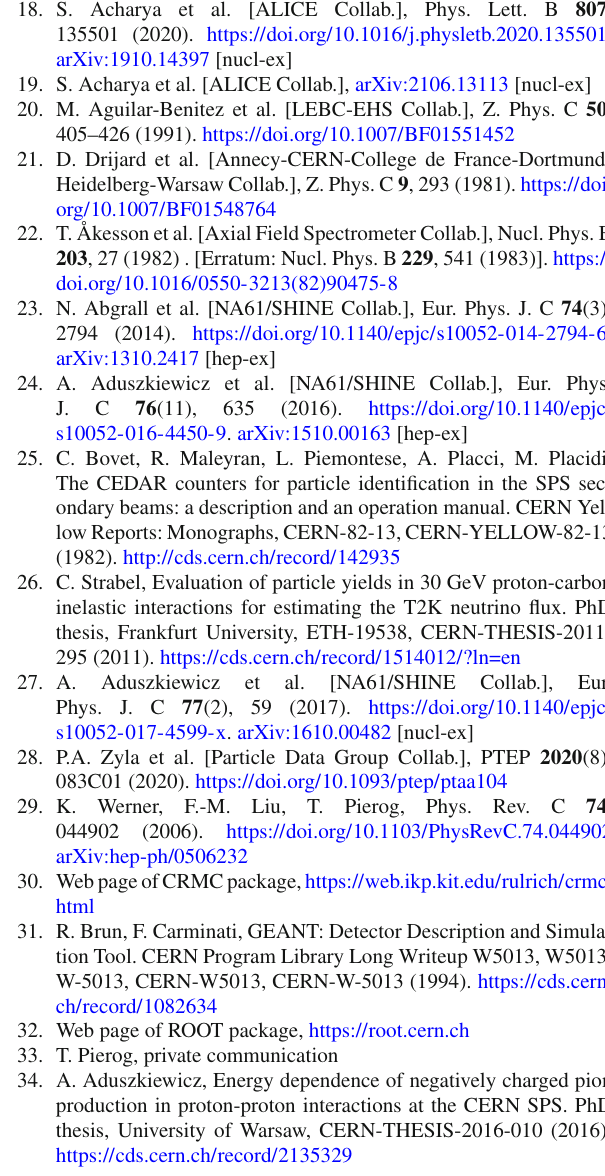
iment. The total uncertainties of (cid:8) K ∗ ( 892 ) 0 (cid:9) , (cid:8) K + (cid:9) , and (cid:8) K − (cid:9) were calculated as the square roots of the sums of squares of statistical and systematic uncertainties p+p at 40 GeV /